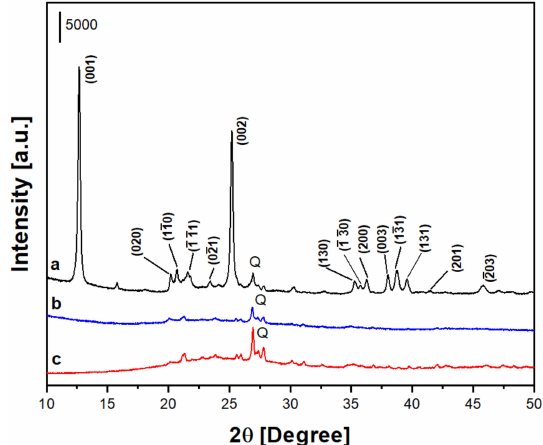
Figure 1. XRD diffraction pattern of kaolinite (a), metakaolin (b), and silica particles